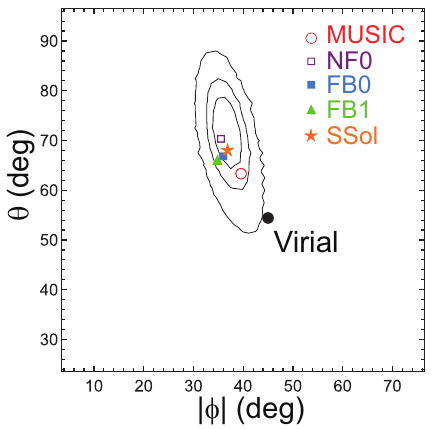
Figure 2. The angle of the plane normal P 3 in the space of ( log r s ,log M s ,log T X ) ; θ is the angle between P 3 and the log T X axis, and φ is the azimuthal angle around the log T X axis, measured anti-clockwise from the log r s axis. The contours are for the CLASH observational data showing the 68% (1 σ ), 90% and 99% confidence levels from inside to outside. The large black dot (Virial) is the prediction of the simplified dimensional analysis or T s ∝ M s / r s and is rejected at the >99% level. The directions of the plane normals estimated for the simulation samples MUSIC, NF0, FB0, and FB1 are shown by the open red circle, the open purple square, the filled blue square, and the filled green triangle, respectively. The prediction of the similarity solution (Equation (9) for n = − 2) is shown by the orange star (SSol) (Figure is reconstructed from Figure 2 of [23]).